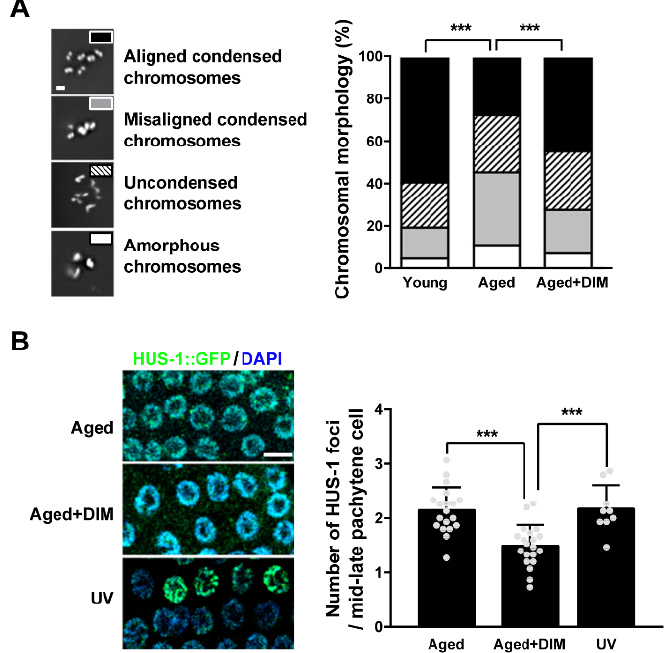
Figure 4. DIM supplementation decreased chromosomal abnormality in reproductively aged Caenorhabditis elegans : ( A ) Representative images and a percentage graph of chromosomal aberrations were shown using DNA staining in the oocytes produced by day 2 adults (Young, n = 105) and day 4 adults supplemented with DMSO (Aged, n = 89) or DIM (Aged+DIM, n = 115). The analysis of chromosomal aberrations was classified into four categories: (1) aligned condensed chromosomes, (2) misaligned condensed chromosomes, (3) uncondensed chromosomes, and (4) amorphous chromosomes. Scale bars represent 2 µ m. ***, p < 0.001 (chi-square test). ( B ) Representative images of the HUS-1 foci (green) in the mid-late pachytene germ cells were shown using anti-GFP immunostaining. The graph indicated the numbers of HUS-1 foci per germ nucleus in day 4 adults supplemented with DMSO (Aged, n = 20) or DIM (Aged+DIM, n = 20) for 24 h. UV treatment was used for the positive control (UV, n = 9). Error bars represent SD. ***, p < 0.001 (one ‐ way ANOVA with Tukey’s post ‐ hoc test). Scale bars represent 10 μ m.